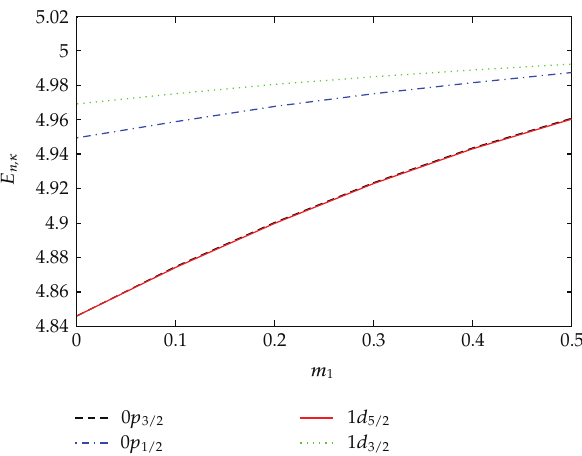
Figure 1: The variation of the energy levels as a function m 1 in the presence of spin symmetry.